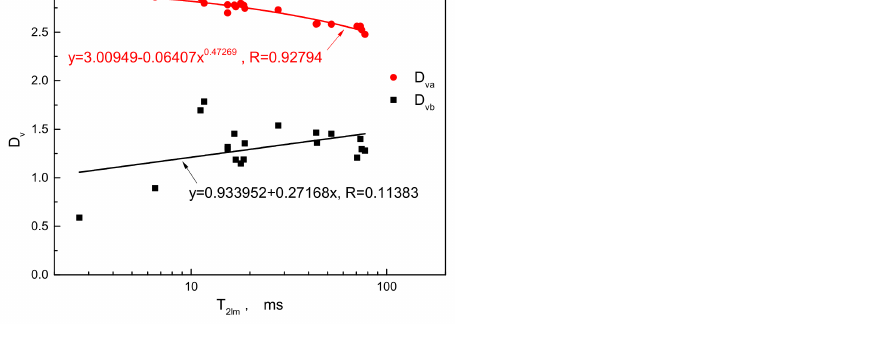
Figure 11. D v —T 2lm relationship ( D va , T 2lm ) and ( D vb , T 2lm ) are marked by red spot and black square,